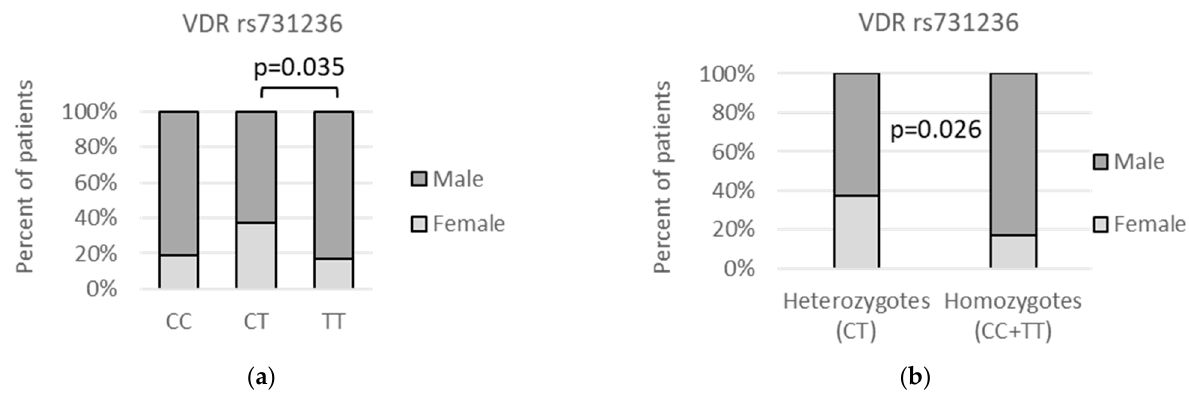
Figure 2. Relationship between VDR rs731236 genetic variants and patients’ gender. The following statistically significant associations were found: ( a ) CT vs. TT , p = 0.035, OR(95%CI) = 3 (1.16 to 7.56); and ( b ) CC + TT vs. CT , p = 0.026, OR(95%CI) = 0.35 (0.14 to 0.85). Analysis was performed using Fisher‘s exact test.